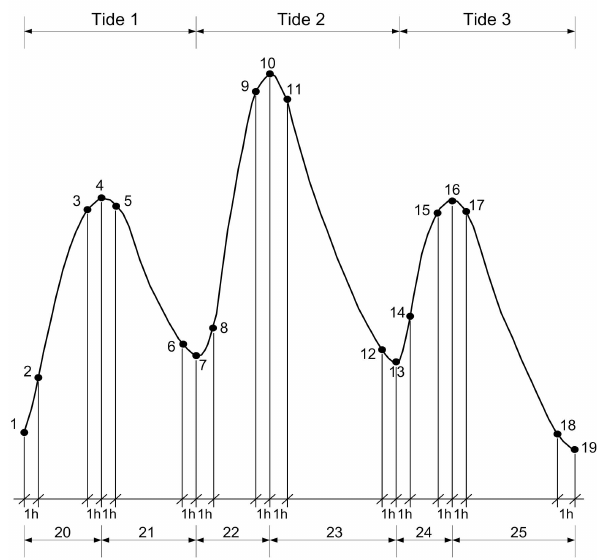
Fig. 6. Parameterisation scheme used to paramterise observed storm surge events consisting of thress tides.